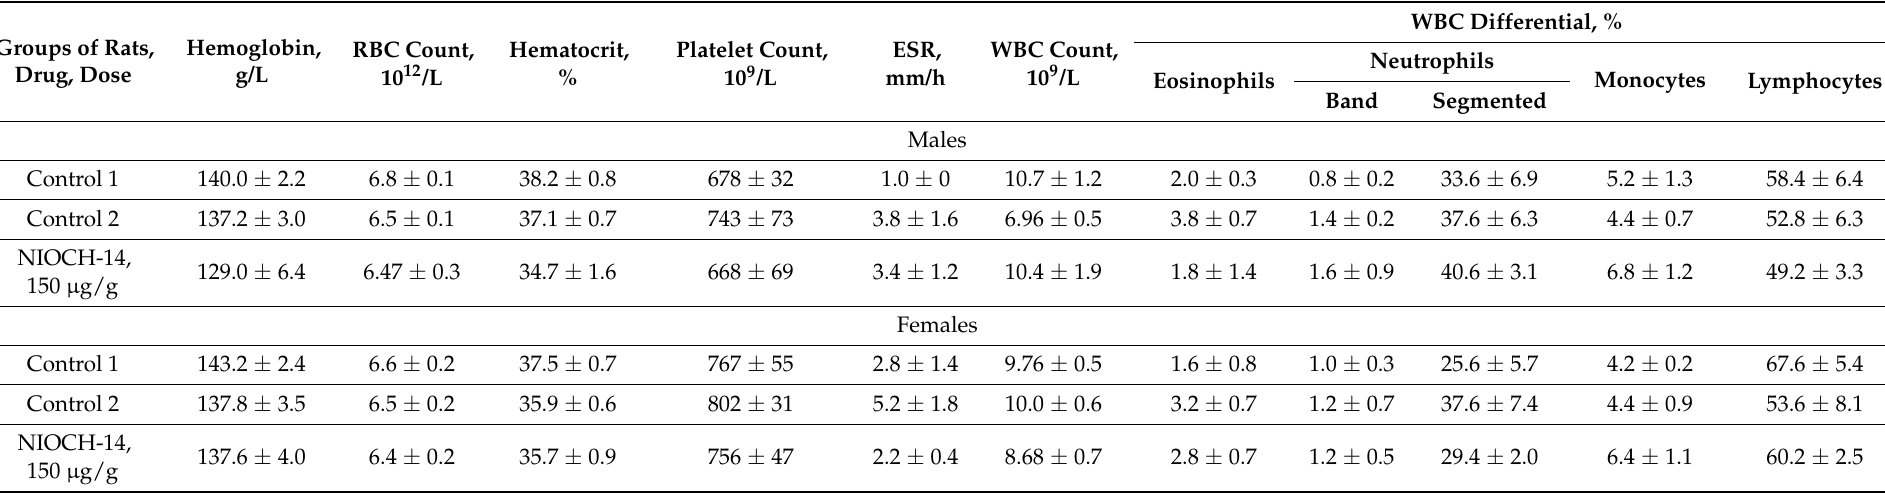
Table 2. Hematological parameters 14 days after single-dose intragastric administration of NIOCH-14 to Wistar rats (150 µ g/g body weight). Groups of